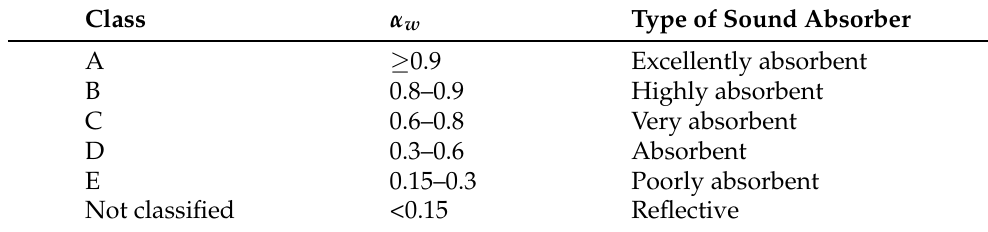
Table 2. Classification of sound-absorbent